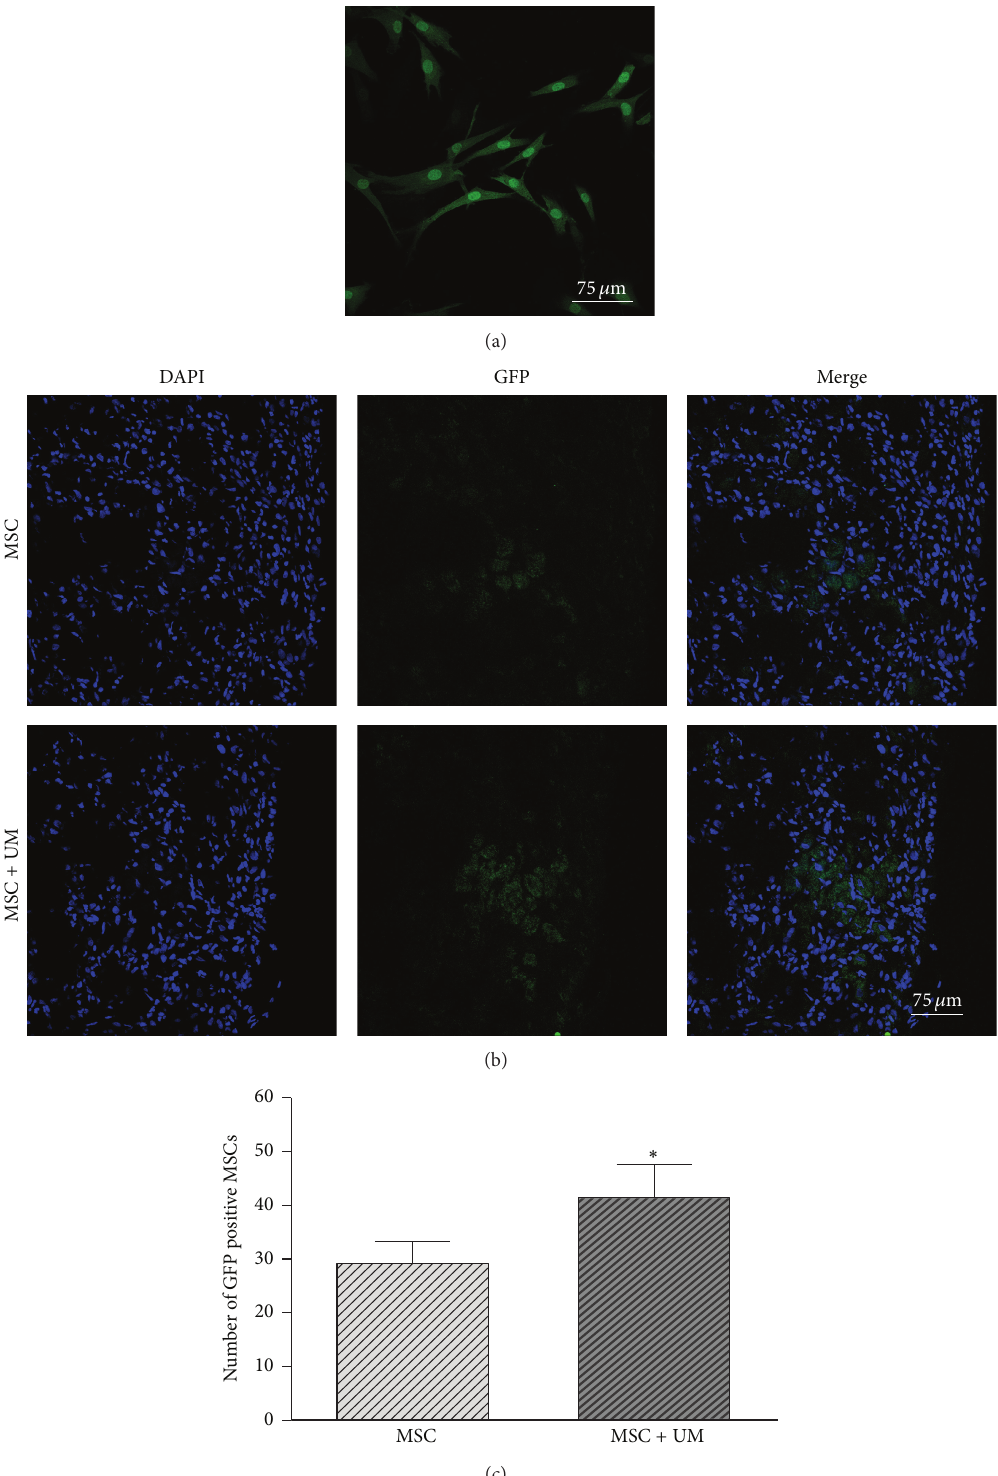
Figure 6: MSC labeling and the distribution of GFP-MSCs in the MI area. (a) MSCs were labeled with GFP; green fluorescence could be observed in both the cytoplasm and nucleus of almost all MSCs under a laser scanning confocal microscope. (b) GFP-positive cells of the MSC group and the MSC + UM group were distributed in MI areas 2 days after transplantation. (c) Quantification of the number of GFP-positive cells in the MSC group and the MSC + UM group. The scale bars represent 75 𝜇 m. All values are expressed as the mean ± SD. ∗ 𝑃 < 0.01 versus MSC group; 𝑛 = 8